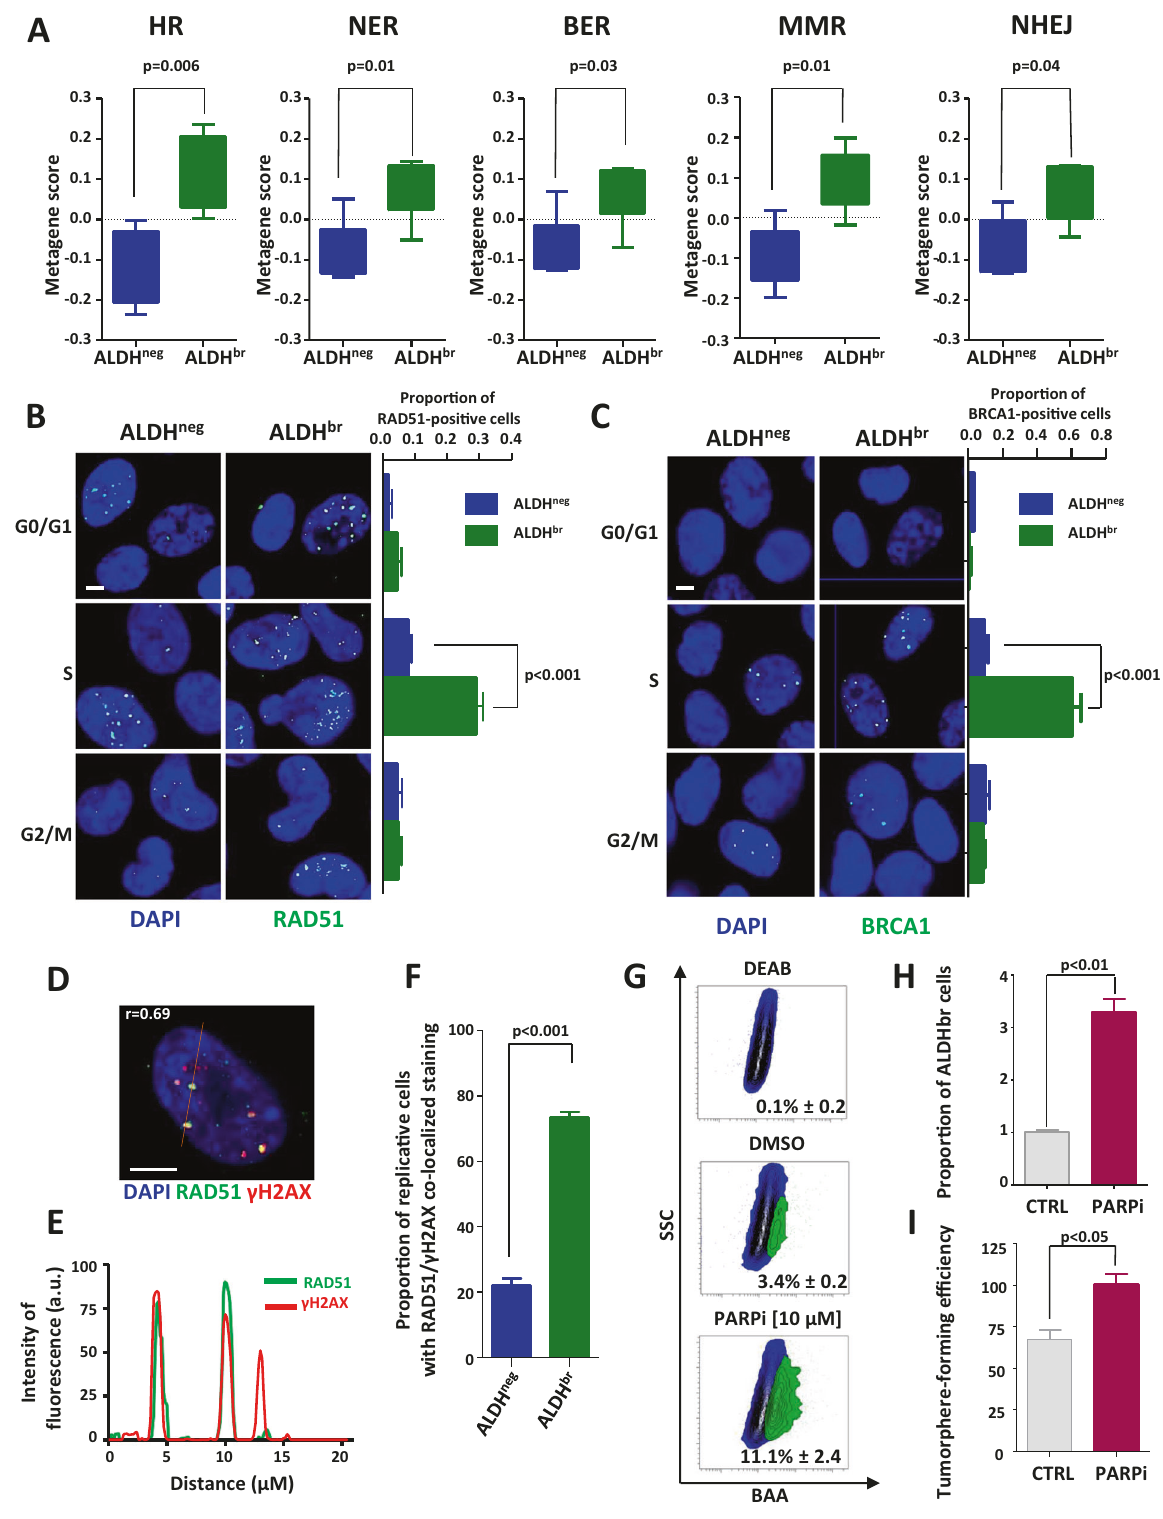
correspond to structures known as “ PcG bodies ” [34, 35] (Supplementary Fig. 3E, F). These PcG bodies were preferentially detected in replicative bCSCs (Fig. 3B). BMI1 recruitment to the DNA damage sites is among the earliest detectable response to DNA lesions [36]. Thus, we hypothesized that PcG